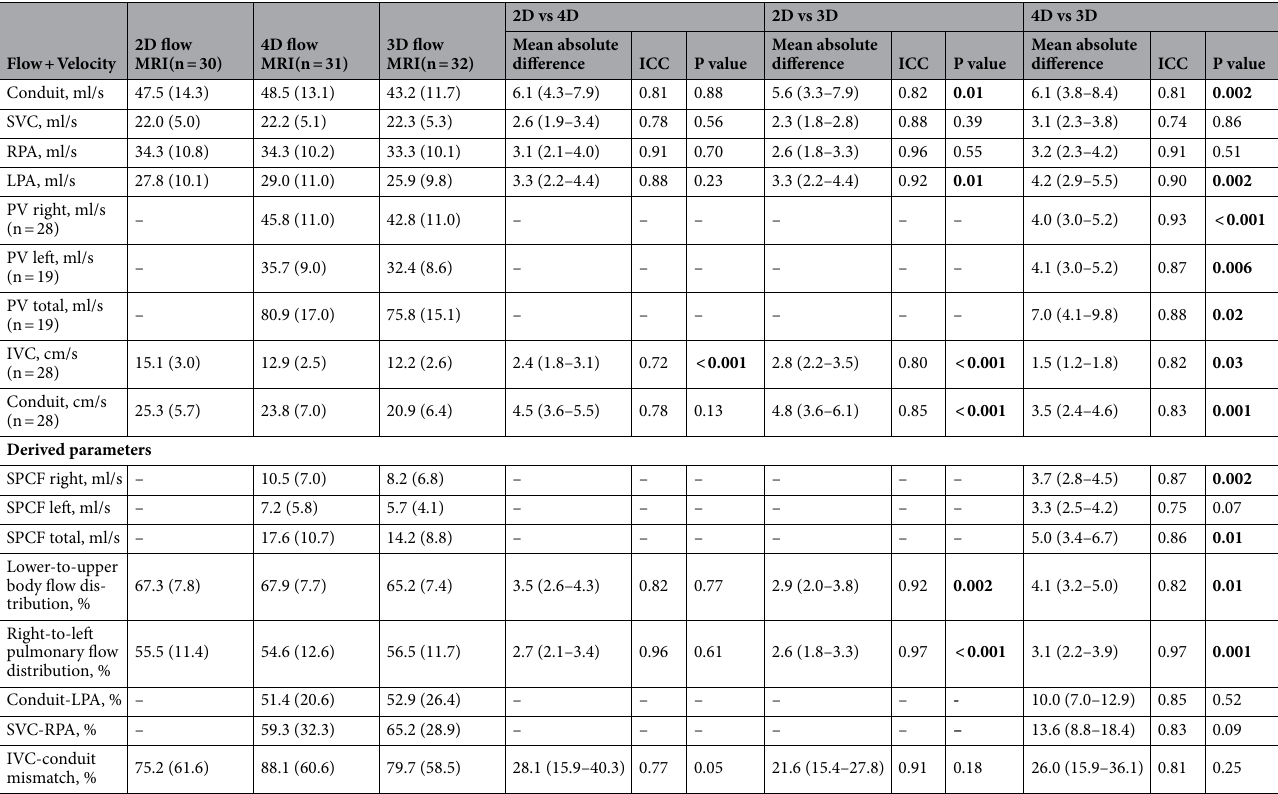
Table 3. Comparison of 2D, 3D and 4D flow MRI measurements in the Fontan pathway. Values are reported as mean (± 1.96 standard error of the mean). P-values < 0.05 of the paired t-tests between acquisitions are indicated in bold. ml/s; milliliter per second, IVC/SVC; inferior/superior vena cava, RPA/LPA; right/left pulmonary artery. PV; pulmonary veins, SPCF; systemic-to-pulmonary collateral